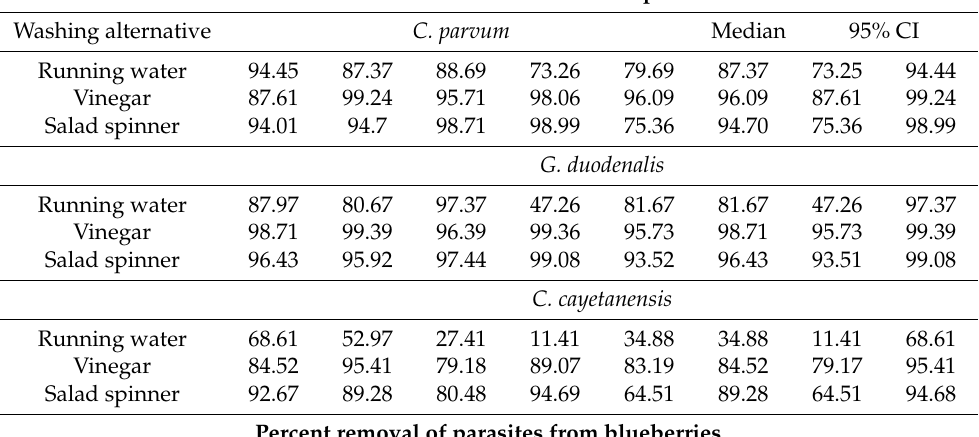
Table 1. Percentage removal of parasites from raspberries and blueberries after washing with three different washing techniques in five